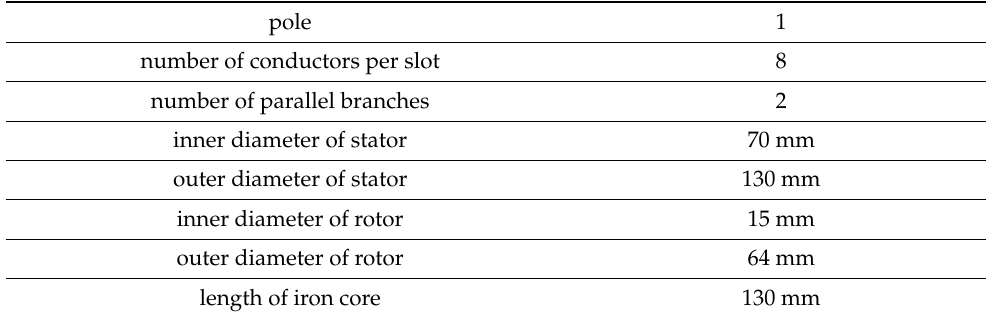
Table 1. Parameters of the simulation model.